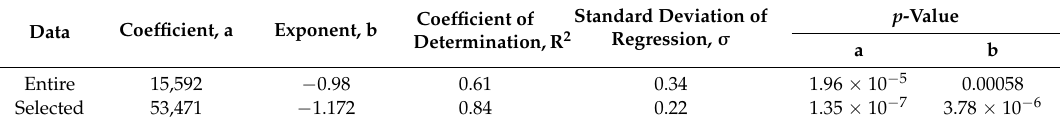
Table 2. Parameters of regression analysis between water contents and electrical